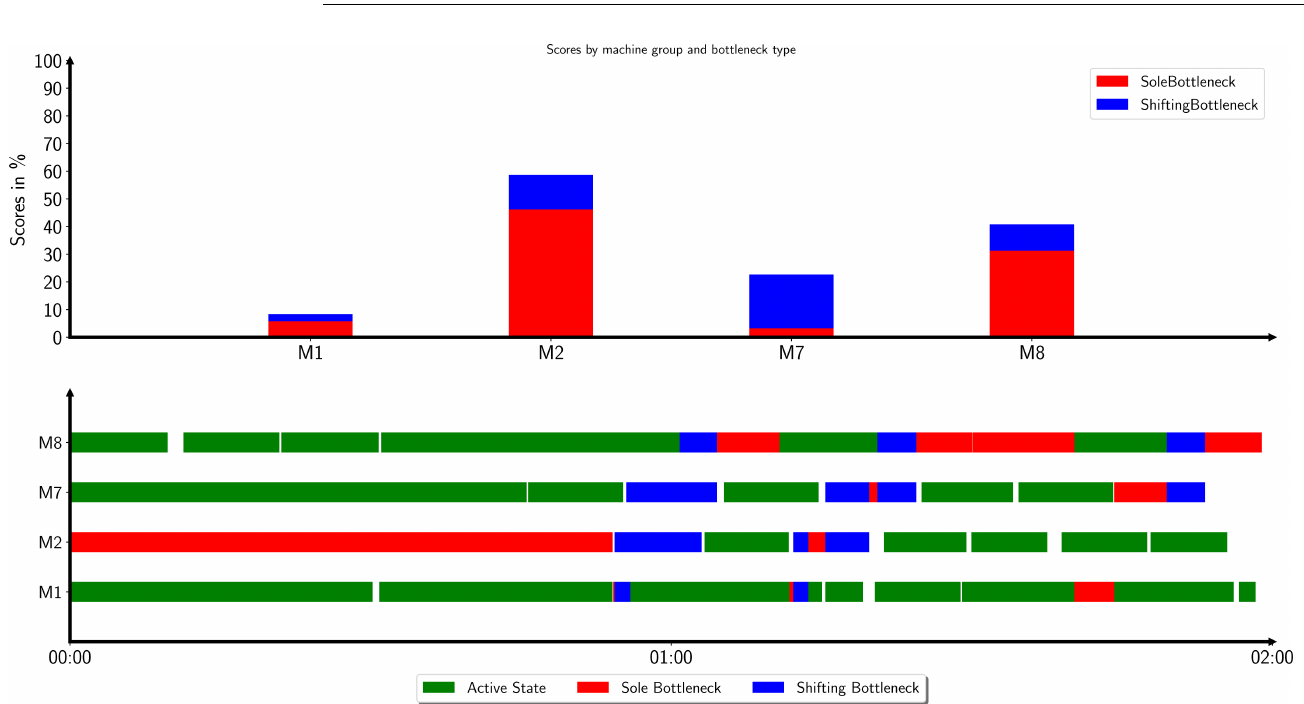
Figure 5. Example of Active Period